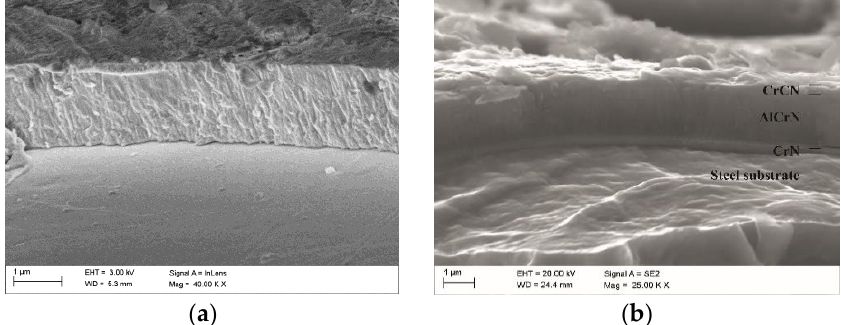
Figure 1. SEM fracture image of ( a ) AlCrN, ( b ) AlCrN + CrCN coating deposited on the steel substrate.